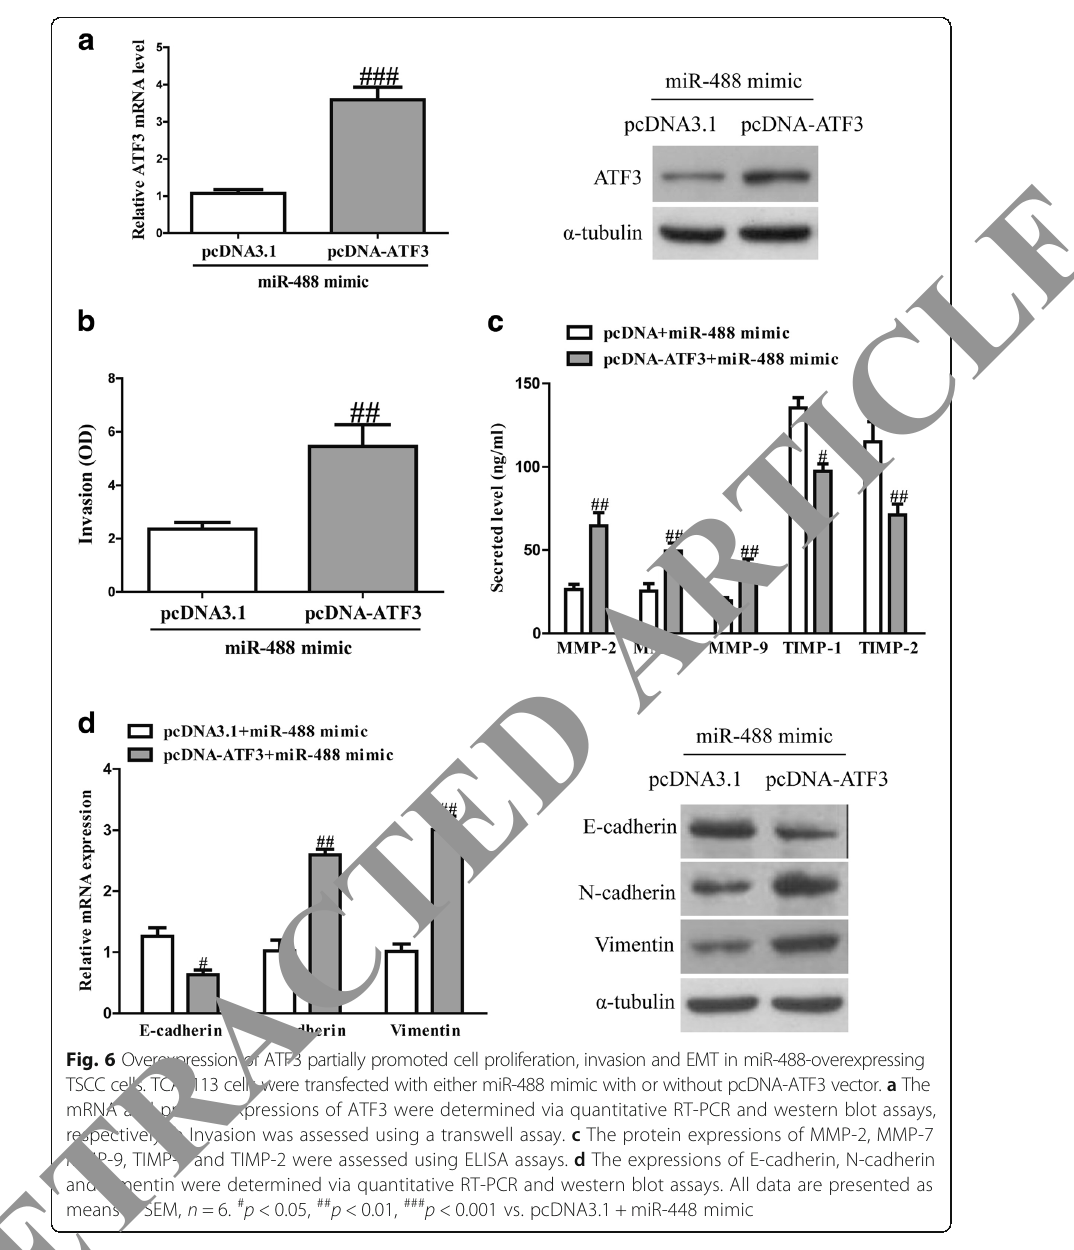
Fig. 6 Overexpression of ATF3 partially promoted cell proliferation, invasion and EMT in miR-488-overexpressing TSCC cells. TCA8113 cells were transfected with either miR-488 mimic with or without pcDNA-ATF3 vector. a The mRNA and protein expressions of ATF3 were determined via quantitative RT-PCR and western blot assays, respectively. b Invasion was assessed using a transwell assay. c The protein expressions of MMP-2, MMP-7 MMP-9, TIMP-1 and TIMP-2 were assessed using ELISA assays. d The expressions of E-cadherin, N-cadherin and vimentin were determined via quantitative RT-PCR and western blot assays. All data are presented as means ± SEM, n = 6. # p < 0.05, ## p < 0.01, ### p < 0.001 vs. pcDNA3.1 + miR-448